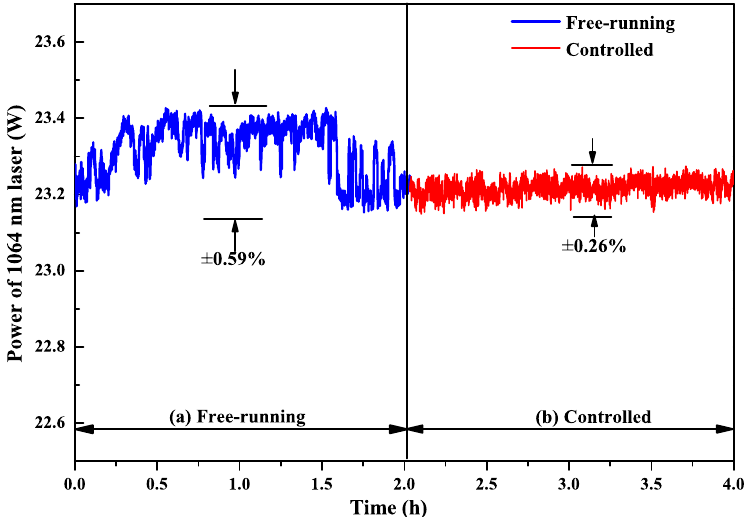
Figure 13. Experimental setup of the single-frequency laser with power stabilization system for fundamental wave [29]. Reprinted with permission from [29] c (cid:13) The Optical Society.